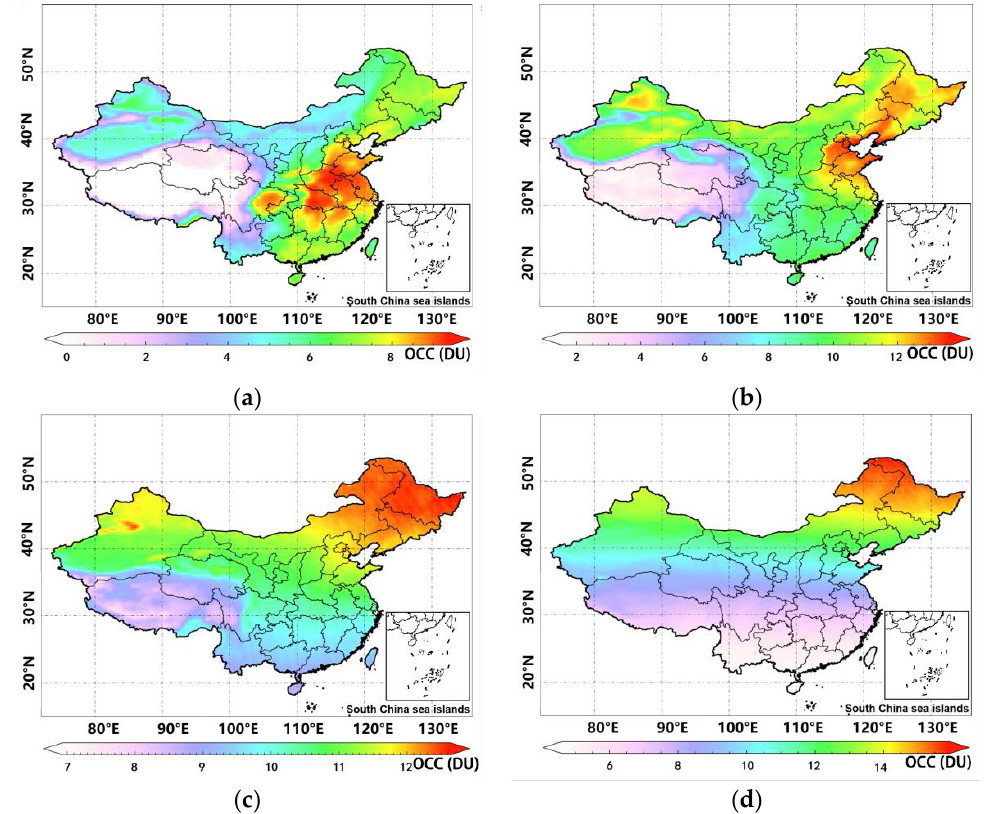
Figure 3. Distribution characteristics of tropospheric ozone at different heights: ( a ) characteristics of ozone distribution at 0 – 3 km in mainland China; ( b ) characteristics of ozone distribution at 3 – 5.8 km in mainland China; ( c ) characteristics of ozone distribution at 5.8 – 9.6 km in mainland China; and ( d ) characteristics of ozone distribution at 9.6 – 12.8 km in mainland China.